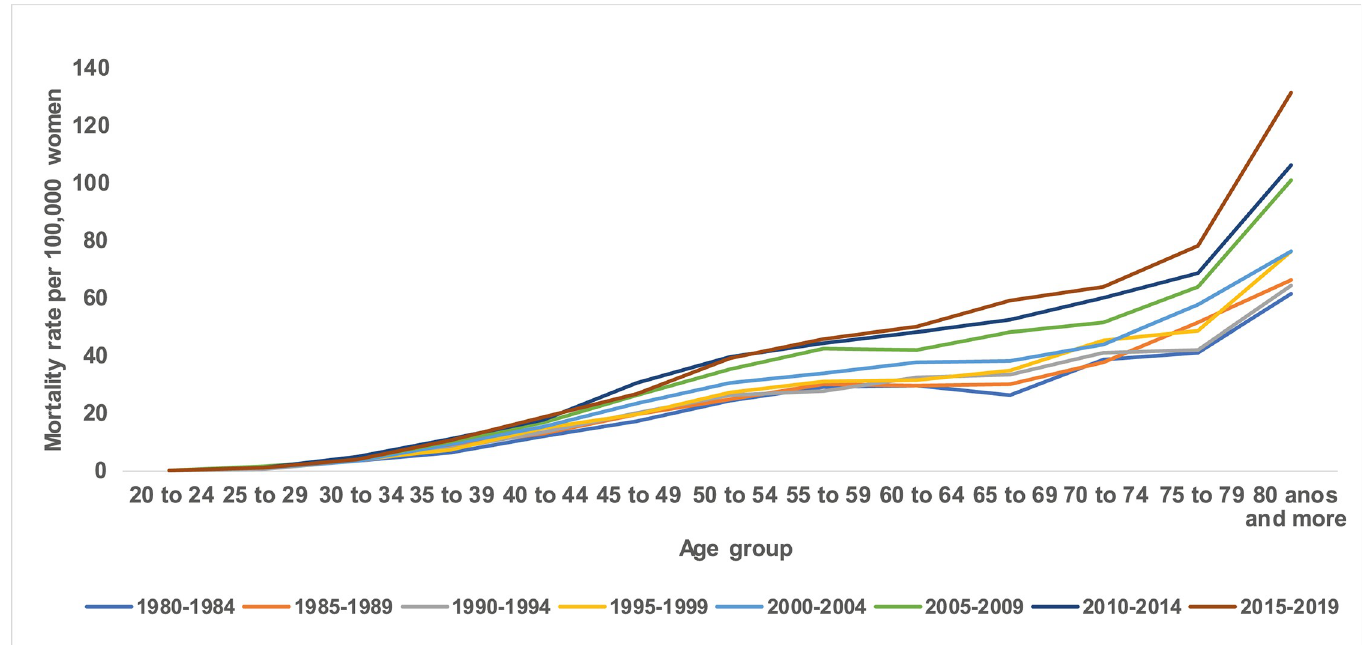
Fig 1. Breast cancer mortality rates by age group and death period in Northeast Brazil,